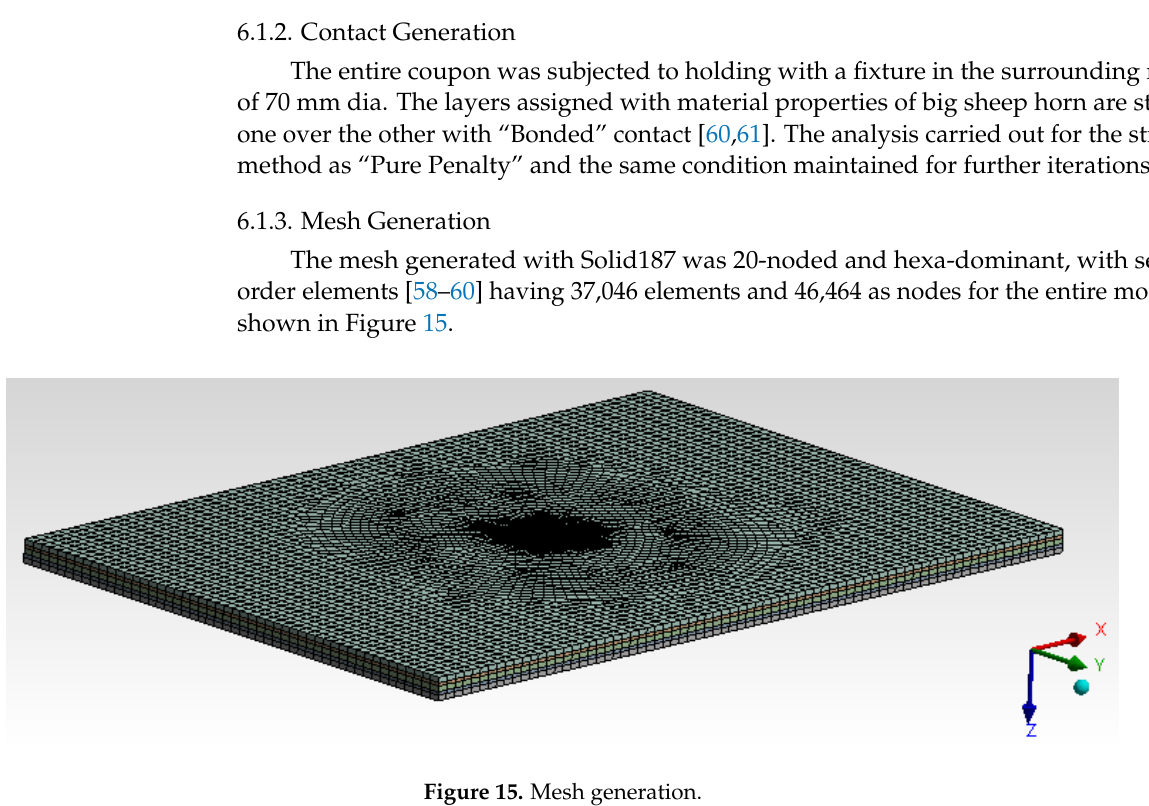
Figure 14. Geometry model.